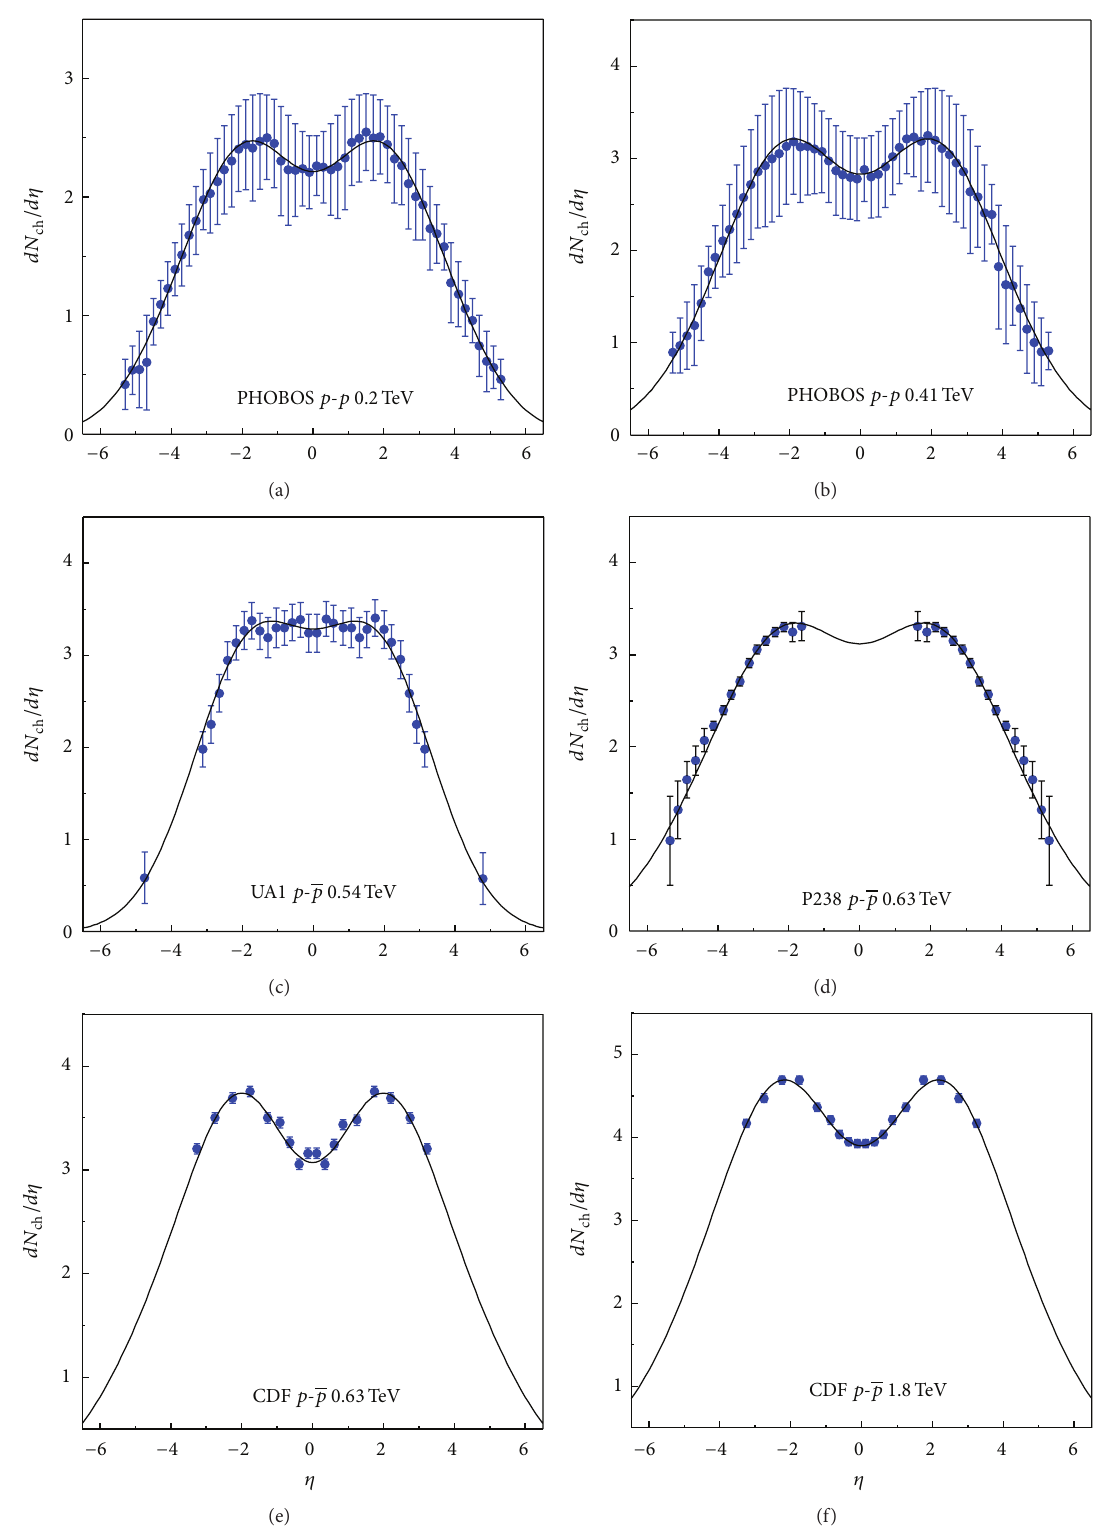
Figure 2: The pseudorapidity distributions of charged particles in inelastic 𝑝 - 𝑝 collisions at √ 𝑠 𝑁𝑁 = 0.2 (a) and 0.41 TeV (b), as well as in inelastic 𝑝 - 𝑝 collisions at √ 𝑠 𝑁𝑁 = 0.54 (c), 0.63 (d, e), and 1.8 TeV (f). The symbols represent the experimental data of the PHOBOS [19] (a, b), UA1 [20] (c), P238 [21] (d), and CDF Collaborations [22] (e, f), respectively. The curves are our calculated